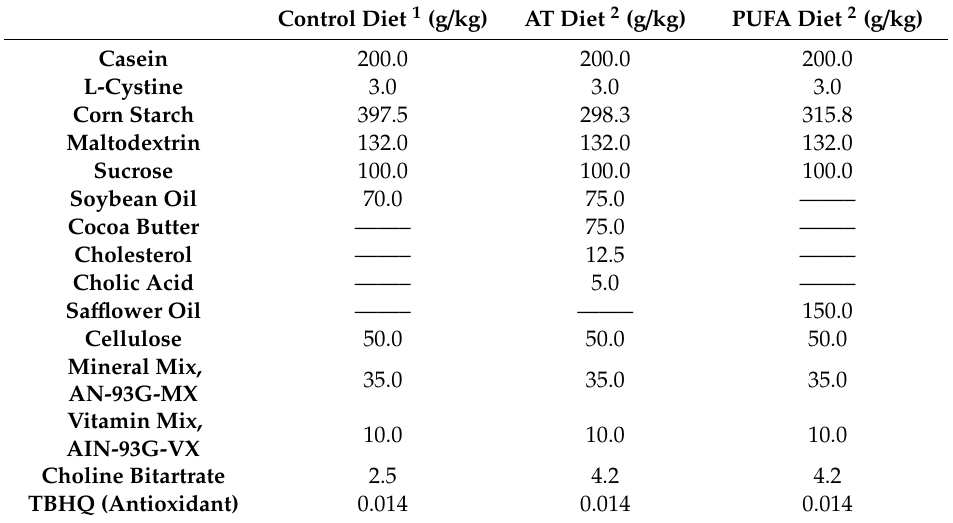
Table 1. Nutrient composition of the experimental diets (Basal, AT, and PUFA) fed to mice for 10 weeks. Control Diet 1 (g /